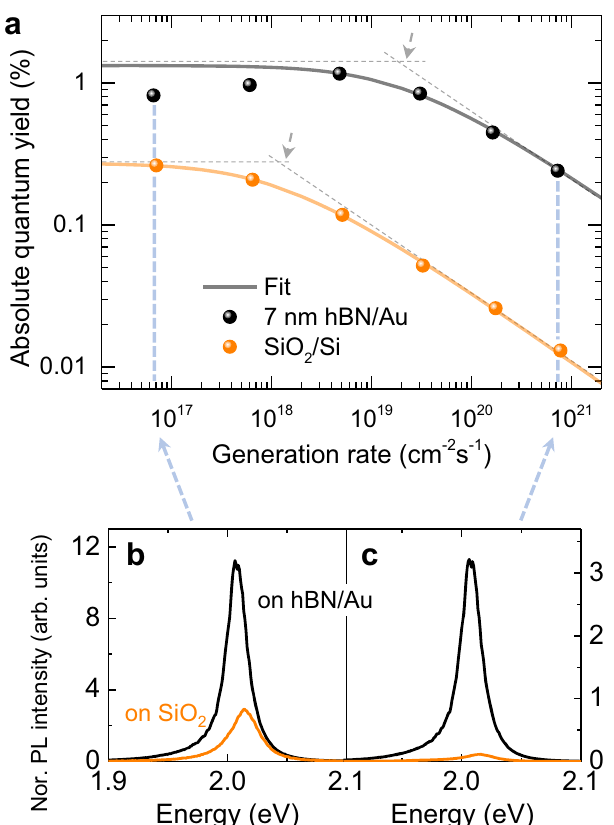
Fig. 4 Enhanced QY by suppressed EEA. a a-QY of 1L-WS 2 on hBN (7 nm)/Au (black dots) and SiO 2 /Si (orange dots) under the generation rate ( G ) varying from 2 × 10 16 cm − 2 s − 1 to 2 × 10 21 cm − 2 s − 1 with the substrate interference effects properly taken into account. The solid curves with each color code are fi ts to the experimental QY calculated with Eq. (5). The dotted lines are guides for eyes and mark the points where the QY droop starts (grey arrows). b and c PL spectra of 1L-WS 2 on hBN (7 nm)/ Au (black) and SiO 2 /Si (orange) at the G value indicated by light blue arrows in a . The PL spectra are adjusted with the substrate interference effect to show the relative